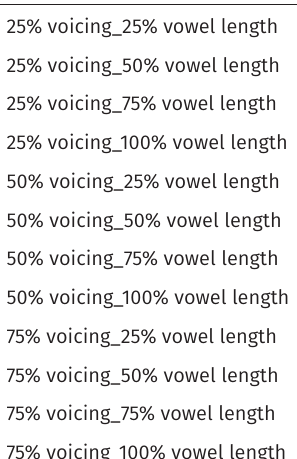
Table 4: Manipulated patterns tested in Experiment